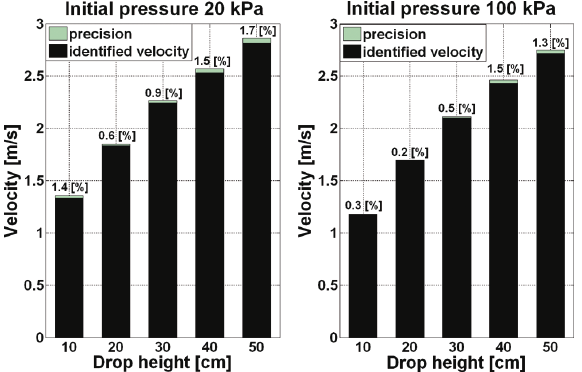
Fig. 10. Mass identi fi cation, experimental results (initial pressure 100 kPa).